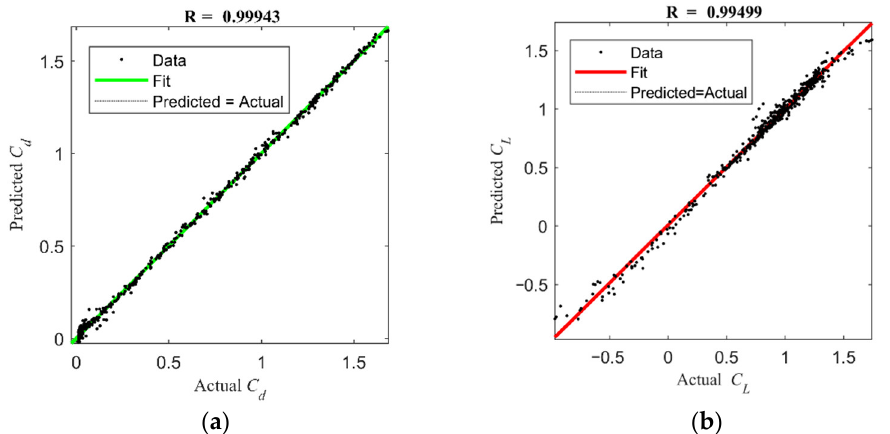
Figure 6. The regression of the trained BP-ANN surrogate model for 2D airfoil aerodynamics. ( a ) C d regression; ( b ) C L regression.